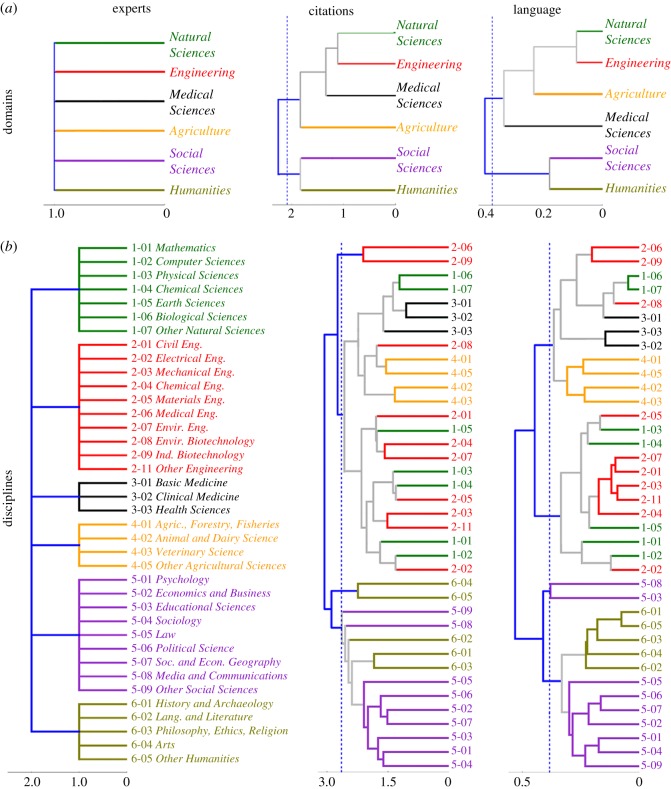
Hierarchical clusterings at the level of domains (a) and disciplines (b). Results for citations (language) were obtained by agglomerative hierarchical clustering, applying the group average method [36] to Dcite(i,j) (Dlang(i,j)). The x-axis shows the clustering dissimilarity (i.e. the dissimilarity of two clusterings that are merged). The dashed line corresponds to a clustering dissimilarity equal to the percentile 0.92 of the values of all cluster dissimilarities at each measure (citations/language).